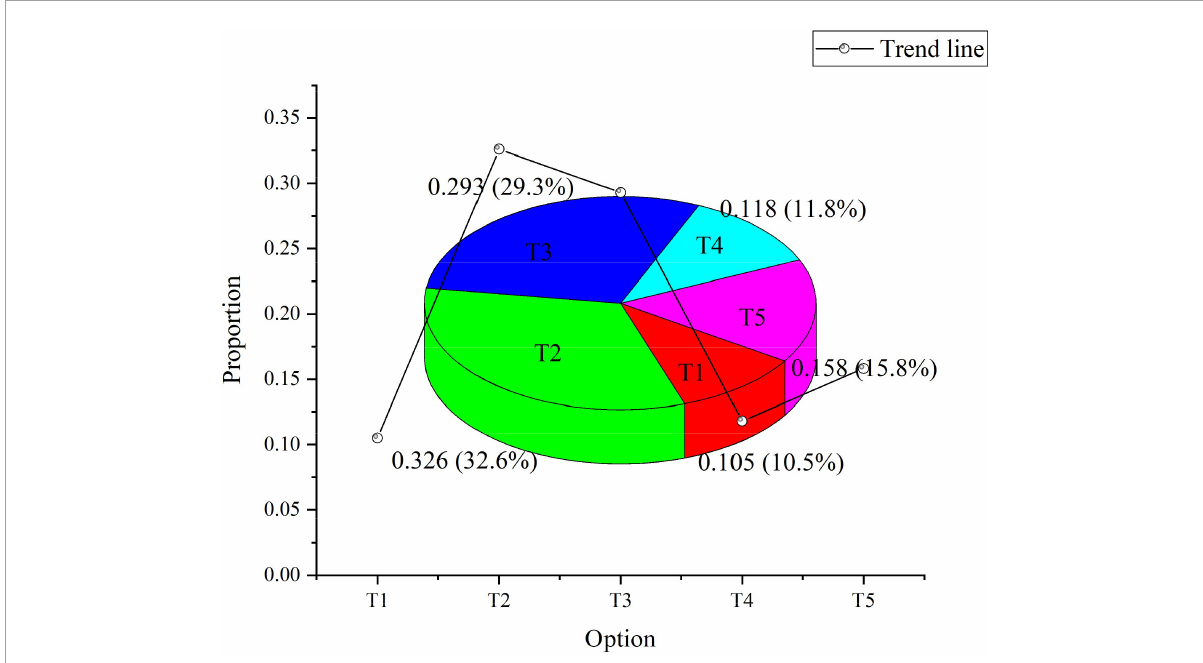
FIGURE4 Social role of entrepreneurial spirit. T1: it can promote the construction of spiritual civilization. T2: it will improve people’s quality. T3: it can promote social harmony. T4: it can promote environmental protection. T5: others.